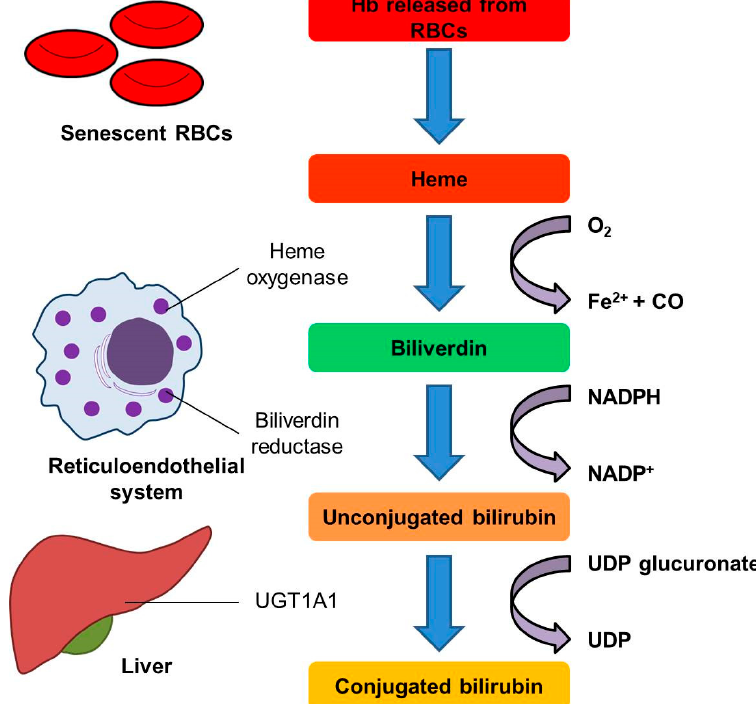
Figure 1. Schematic representation of bilirubin metabolism. Heme released from senescent red blood cells can be readily oxidized by heme oxygenase to biliverdin, which is subsequently reduced to bilirubin by biliverdin reductase. Biliverdin reductase is found in all tissues under physiological conditions, but especially in reticuloendothelial macrophages of the kidney, spleen, liver and brain [5]. Bilirubin binds to albumin and is then transported to the liver, where it is conjugated by UGT1A1 with UDP-glucuronic acid to increase its solubility in water. Abbreviations: CO, carbon monoxide; NADP + , nicotinamide adenine dinucleotide phosphate; NADPH, the reduced form of NADP + ; RBCs, red blood cells; UDP, uridine diphosphate; UGT1A1; uridine diphosphate-glucuronyl transferase 1A1.